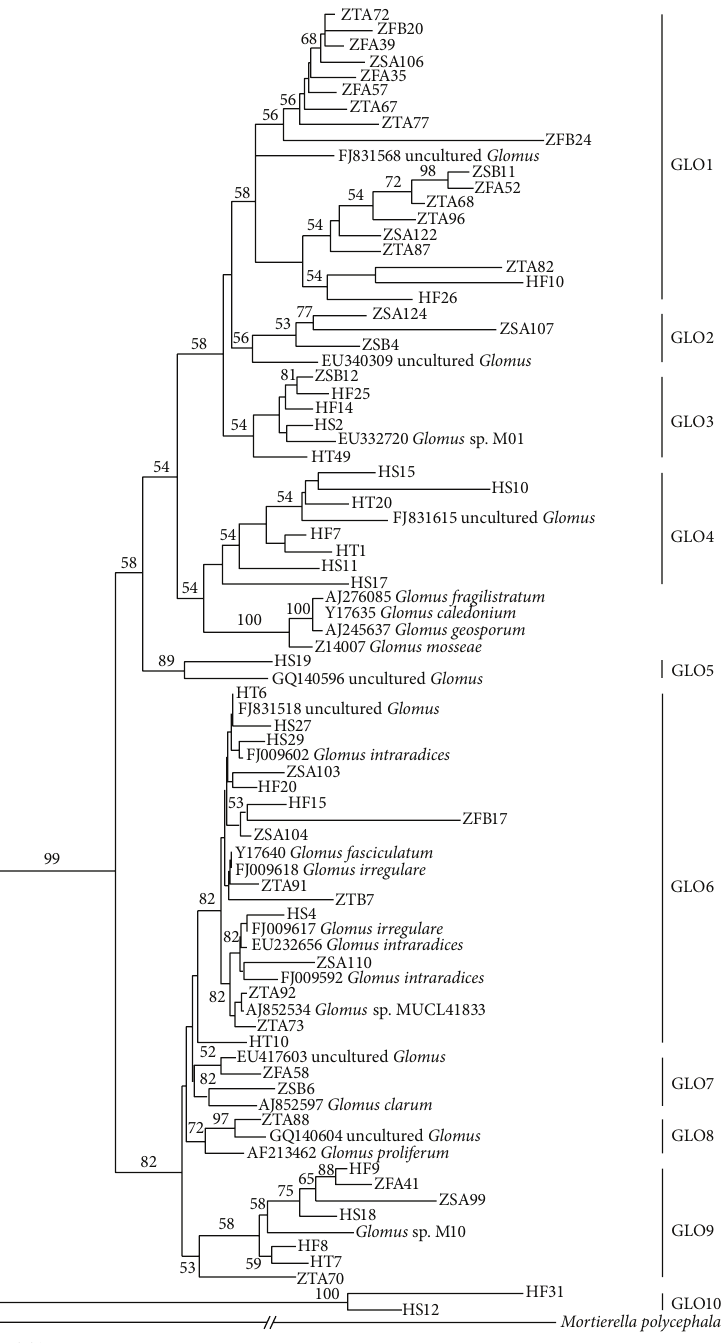
Figure 4: Neighbor-joining tree derived from the AML1-AML2 SSU rDNA sequences from AM fungi colonizing roots of trifoliate orange and red tangerine in orchards. The clone initial letter “Z” represents trifoliate orange and “H”: red tangerine, respectively. The rest of the letters and numbers were clone coded representation. Others were reference sequences searched in GenBank. Bootstrap values were calculated from 1000